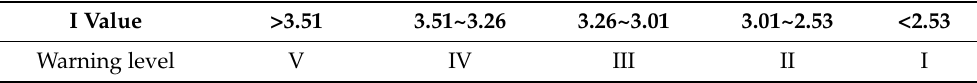
Table 9. Classification of consequences of oil spill risk